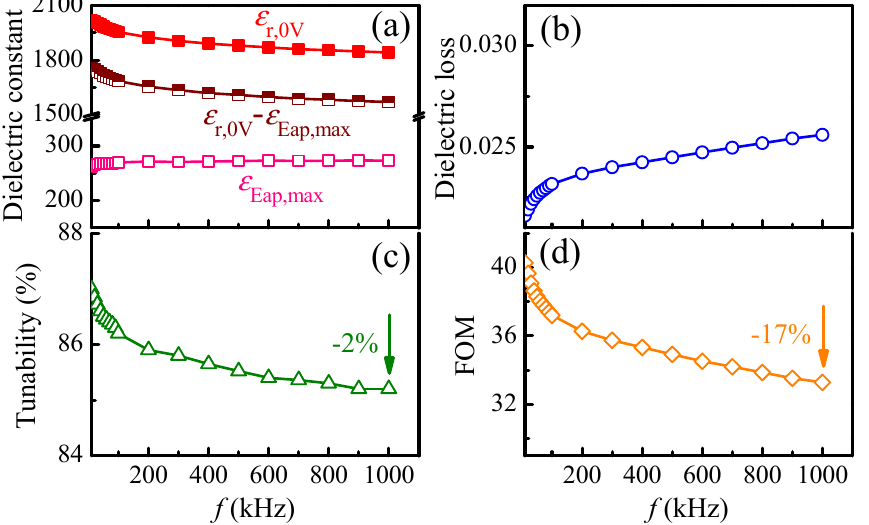
Figure 4. Operating frequency dependent ( a ) dielectric constant at zero field ( ε r,0V ) and at certain bias field ( ε Eap ), ( b ) dielectric loss at zero field (tan δ ), ( c ) tunability ( T ) and ( d ) figure-of-merit ( FOM ), of 1000-nm PLZT films. The measurements were done at 800 kV/cm.